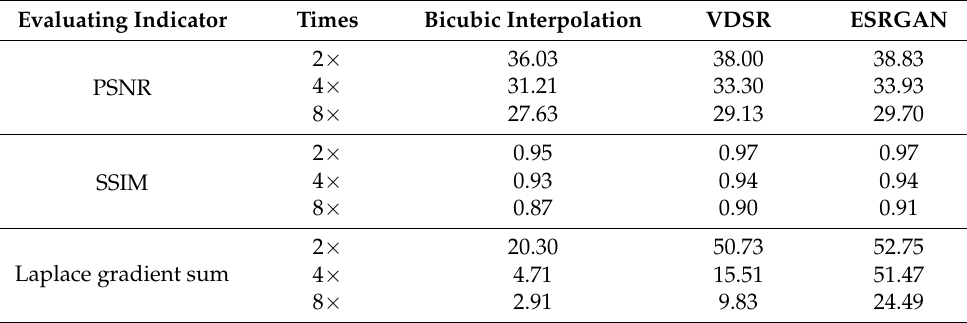
Table 1. Comparison of super-resolution